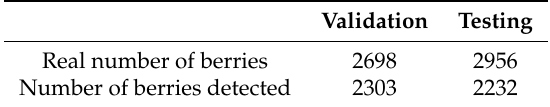
Table 2. Summary of fruits detection rates for testing and validation